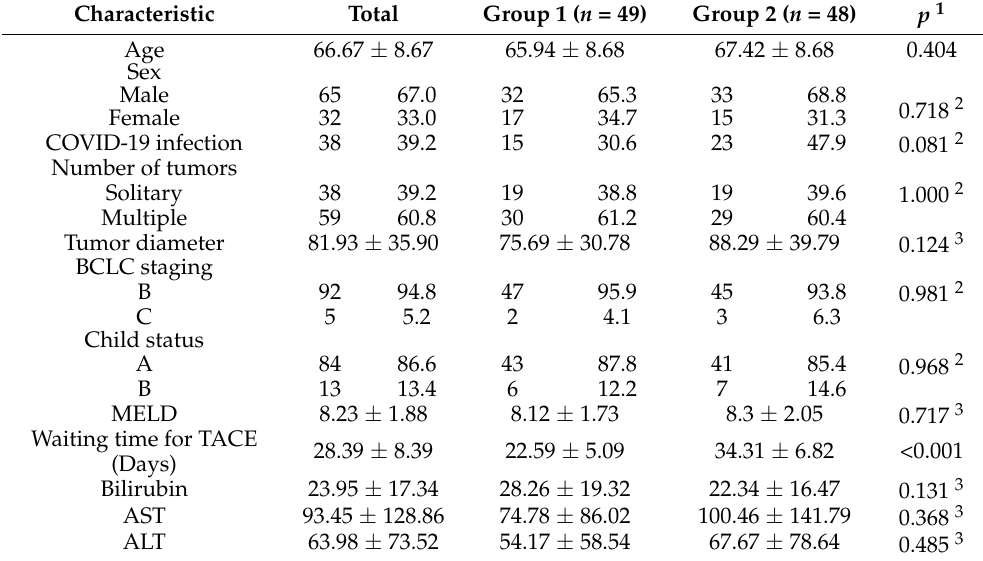
Table 1. Demographic and clinical